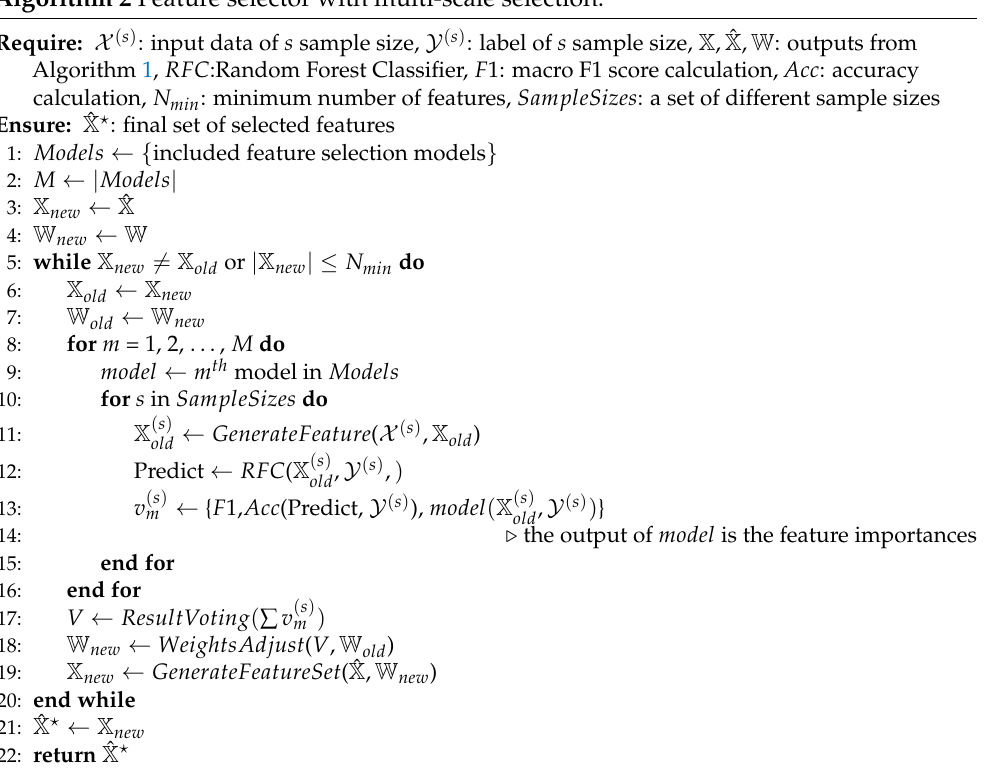
Algorithm 2 Feature selector with multi-scale